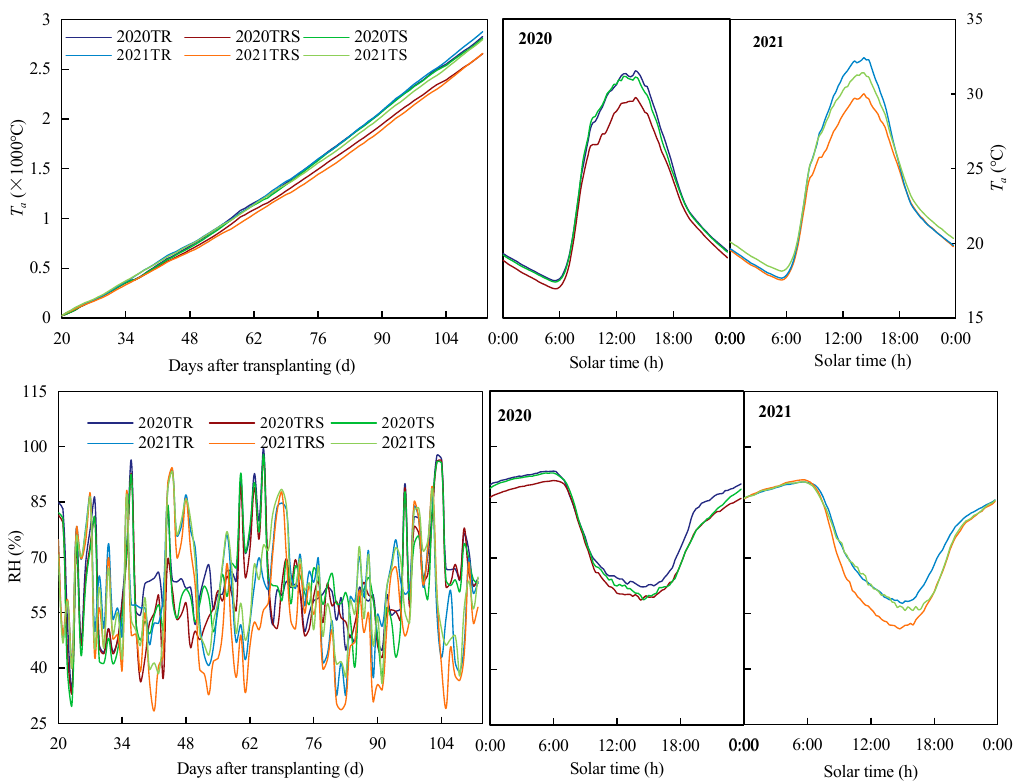
Figure 2. Characteristics of air temperature ( T a ) and relative humidity (RH) under different ventilation treatments in 2020 and 2021.